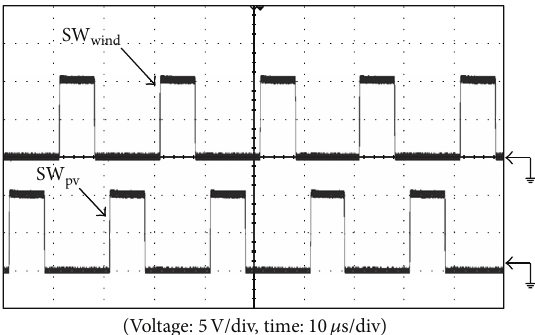
Figure 22: Measured control signals while hybrid wind-PV power is 700 W.